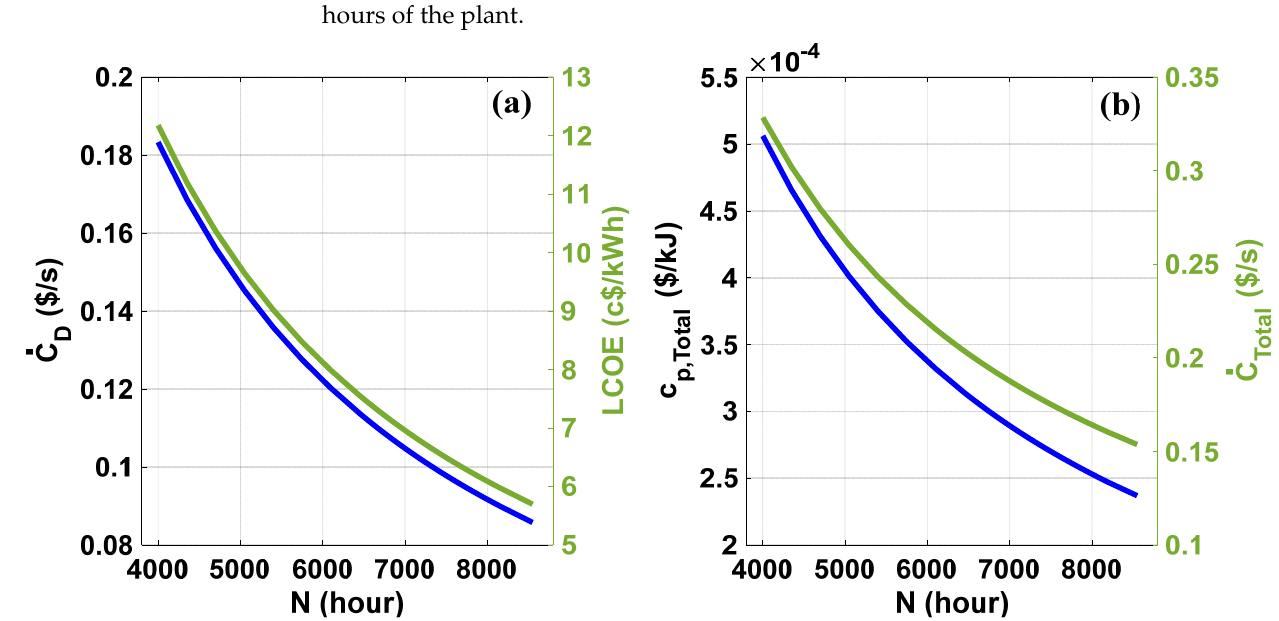
Figure 10. ( a ) Exergy destruction cost and levelized cost of energy variations against plant working hours. ( b ) Production and total cost rate variations against power plant working hours.